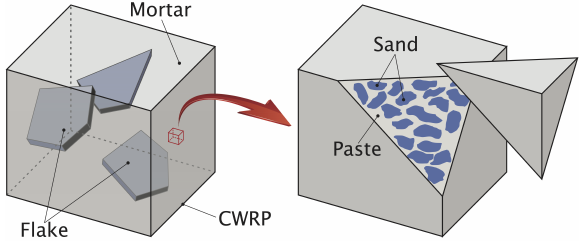
Fig. 3. Two - scales homogenization